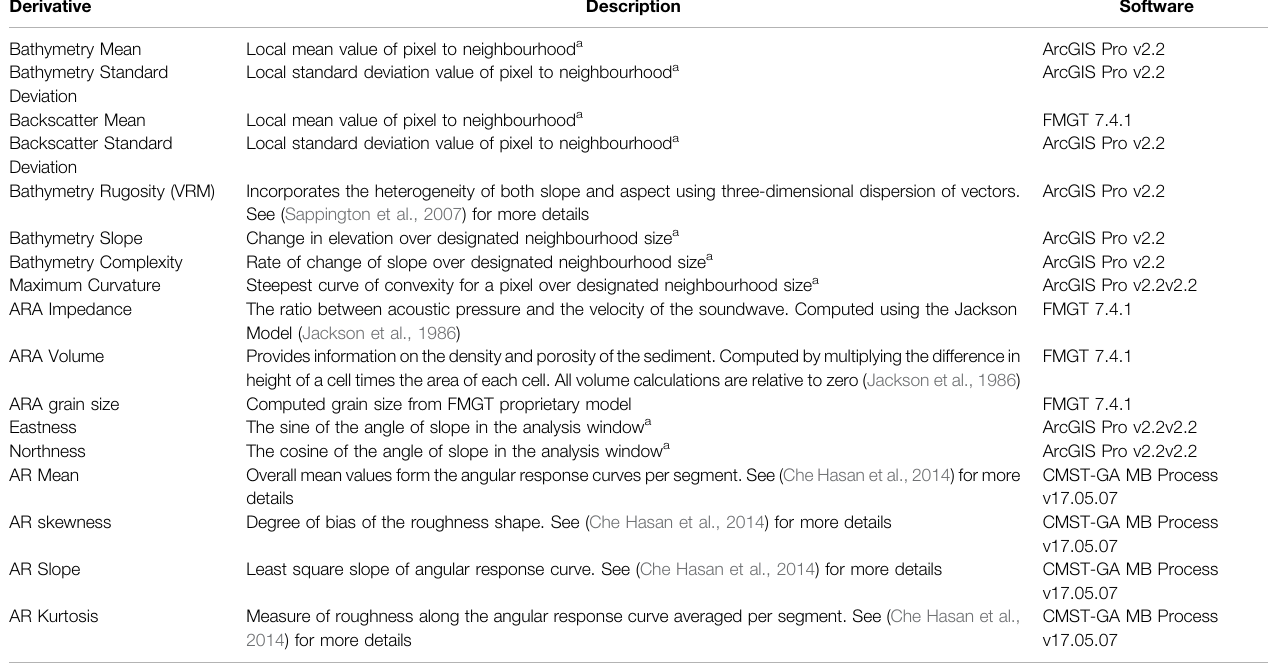
TABLE 1 | List of bathymetry and backscatter derivatives and their respective